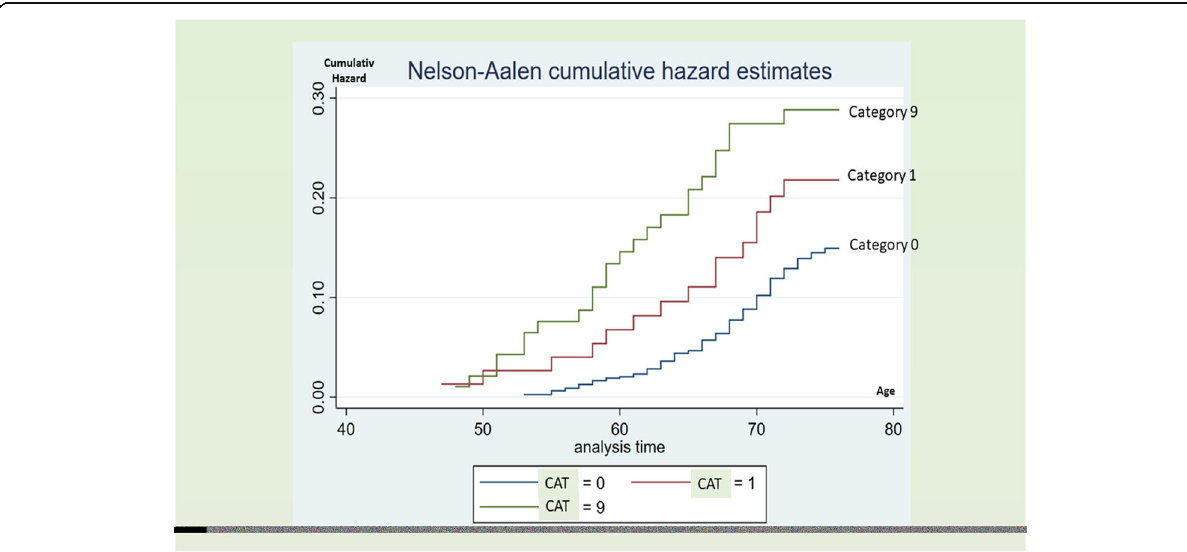
Fig. 1 Nelson-Aalen Cumulative Risk Estimates for Death by category in 977 men. Note: ECG category 0, ECG performed in 1993 and 1998, no ECGA; ECG category 1, ECG performed in 1993 and/or 1998 with one or more abnormalities; and ECG category 9, ECG performed in 1993 or 1998 without